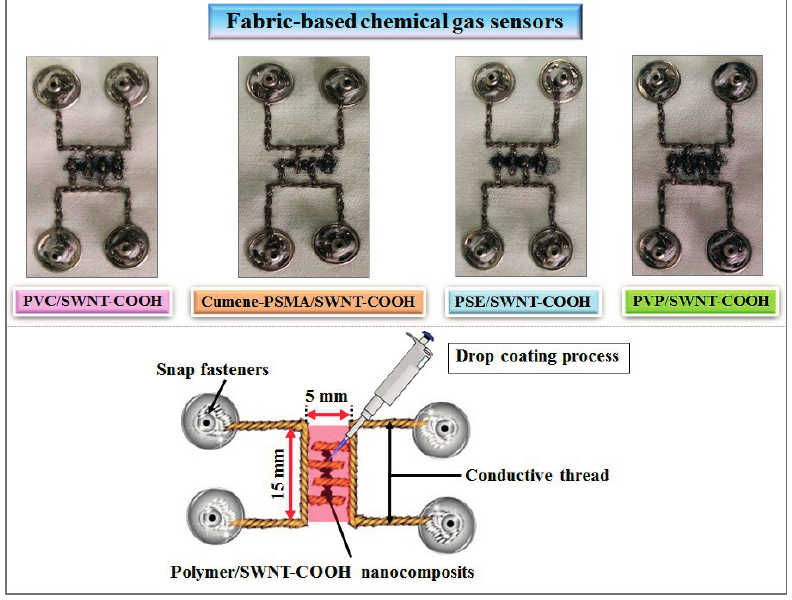
Figure 2. Pictures ( top ) and diagram ( bottom ) of the fabric-based chemical gas